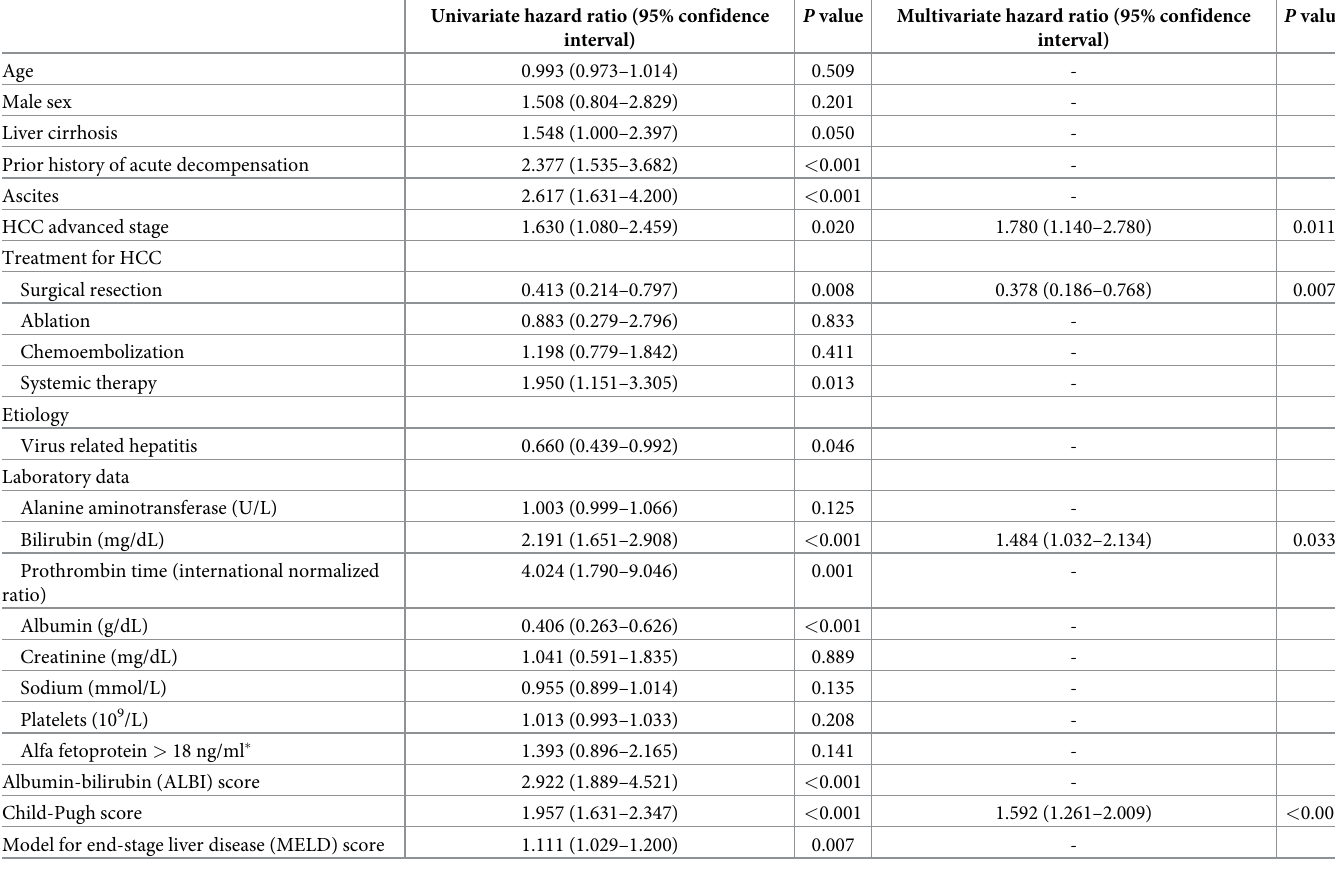
Table 8. Cox regression analyses of predictive factors for the development of acute decompensation in the intermediate-advanced-stage